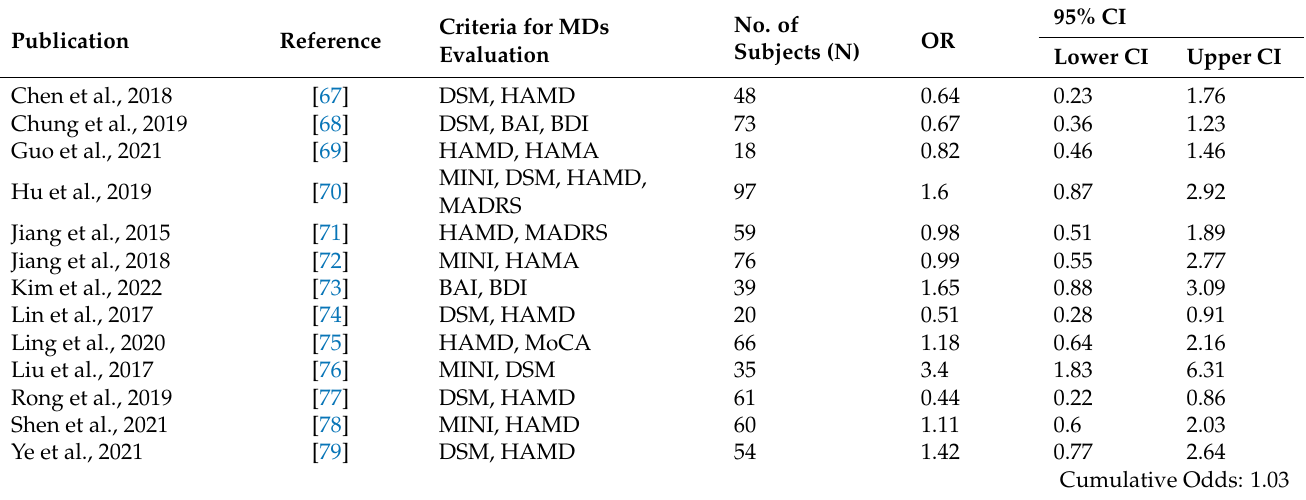
Table 3. Microbiota and MD data from the considered